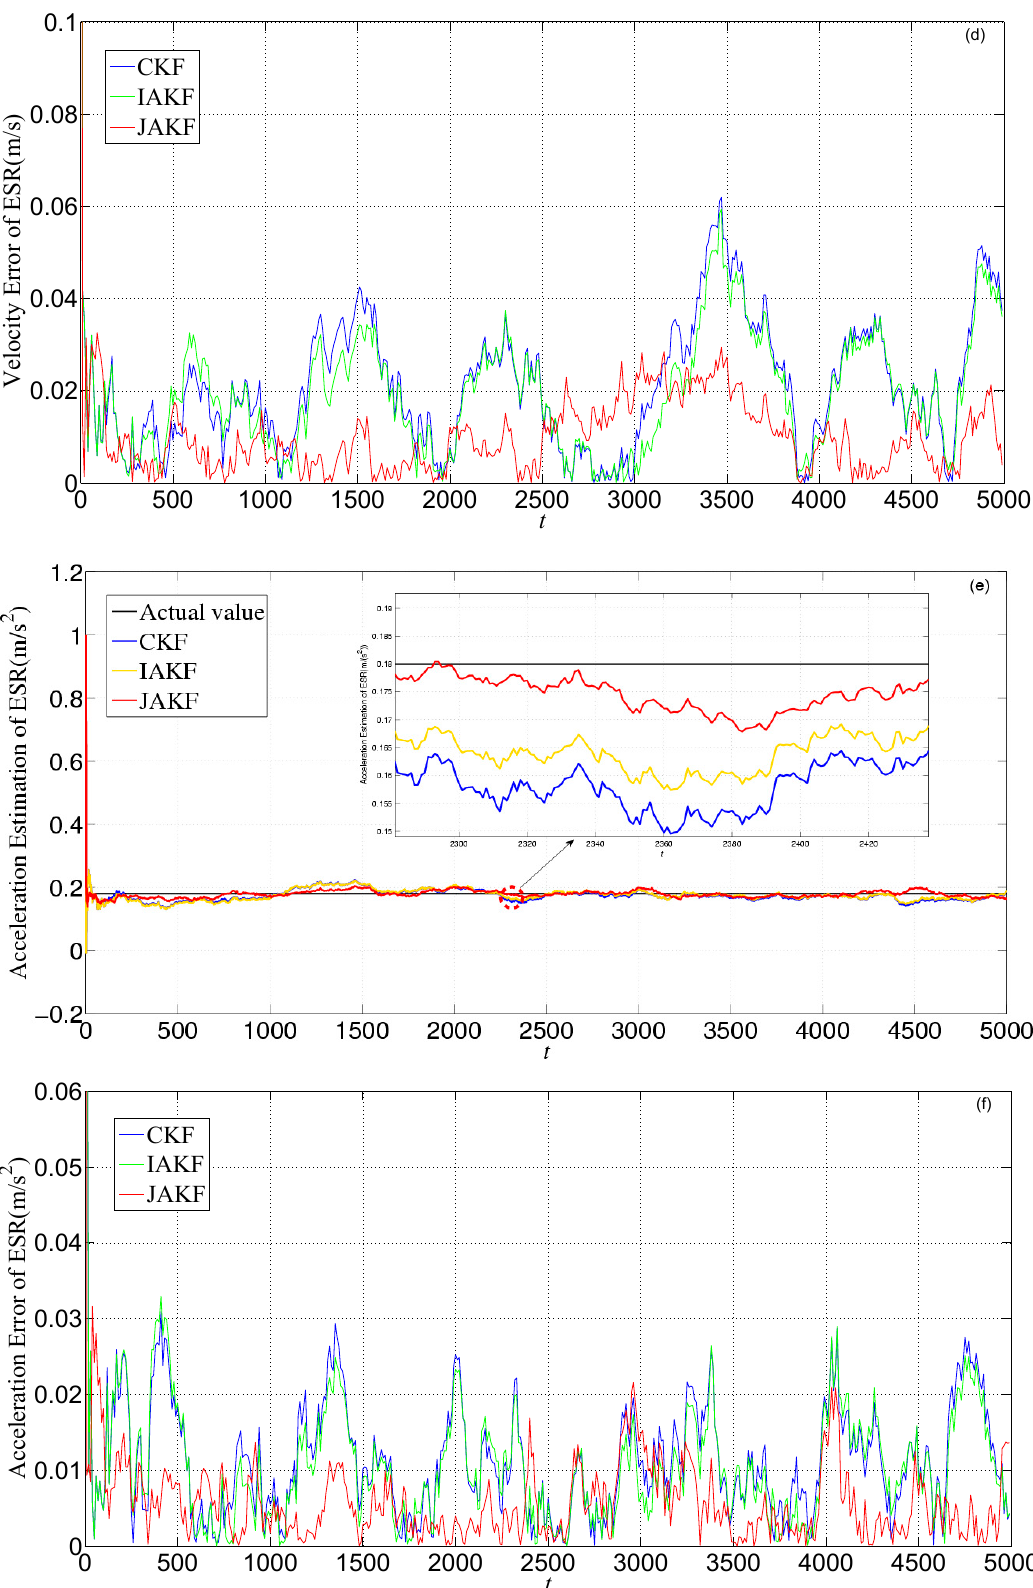
Figure 11. Estimation and error comparison of ESR in the first experiment: ( a ) Displacement estimation of ESR; ( b ) Displacement error of ESR; ( c ) Velocity estimation of ESR; ( d ) Velocity error of ESR; ( e ) Acceleration estimation of ESR; ( f ) Acceleration error of ESR.